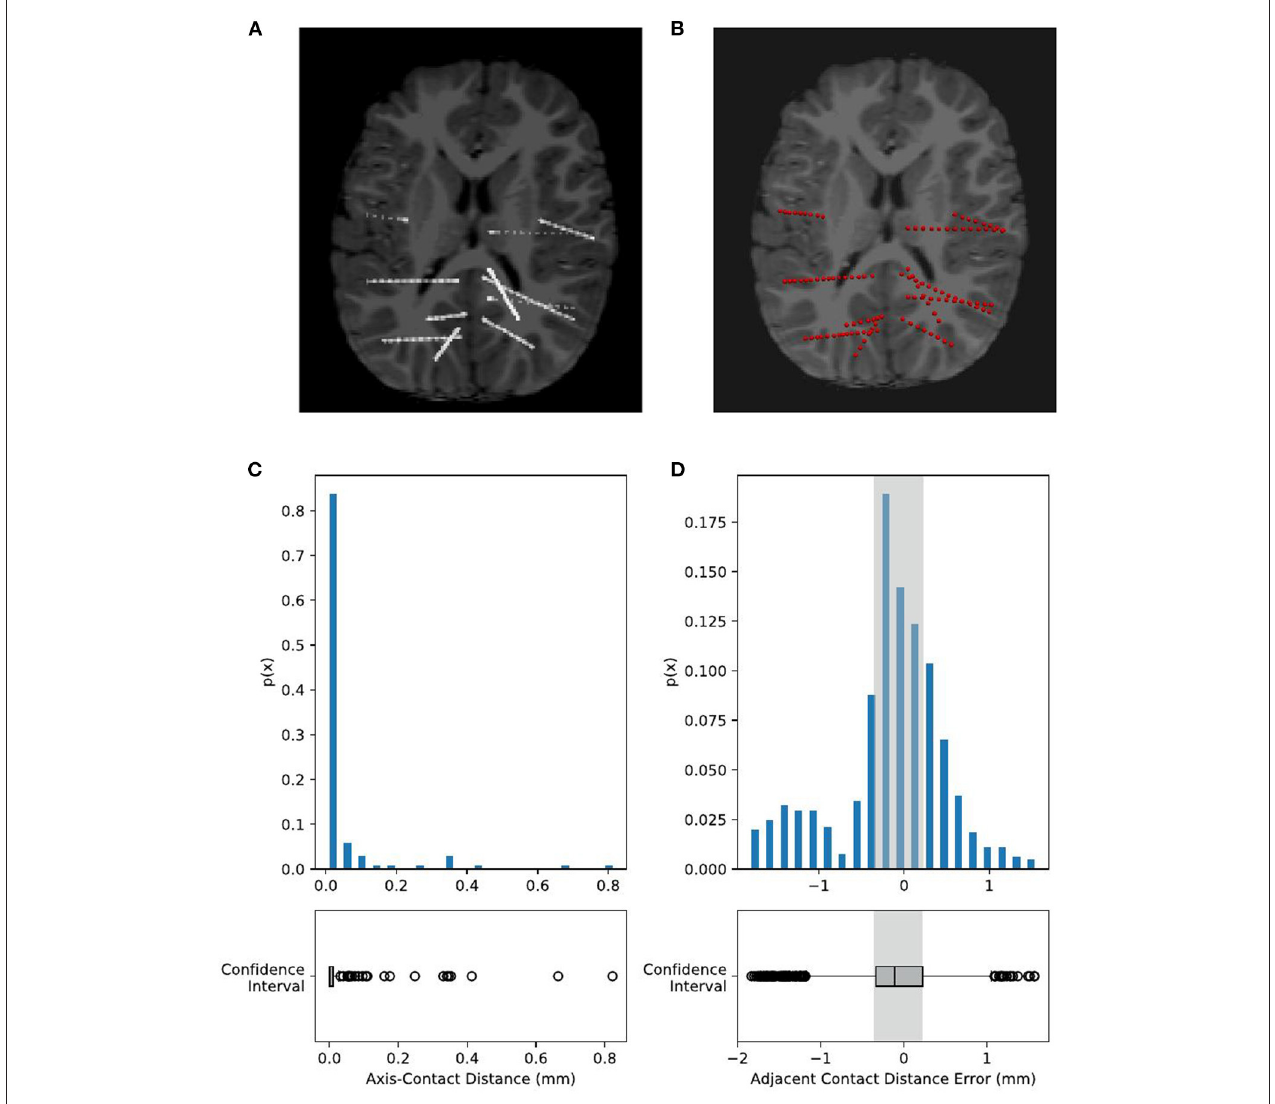
FIGURE 7 | Validation of electrode localization accuracy. Visual checking of the electrodes and contacts of an example subject projected onto the CT image of an individual. The raw CT brain (A) shows electrode positions as highlighted line-shaped voxels. Our recognized electrodes (red spheres) are plotted on (B) , showing that they are overlapped with each other. Contact positions are quantitatively estimated by two metrics, namely, axis-contact distance and adjacent contact distance error. (C) Axis-contact distance estimates the distribution of deviation distance between each contact and its regressed electrode shaft line. Of note, 95% of the contacts were less than 0.1mm, deviating from their estimated shaft line. (D) Adjacent inter-contact distance error estimates the distribution of the distance between each pair of adjacent contacts. The actual adjacent contact distance size, 3.5mm, is subtracted from the estimated distances, so here we have shown the distribution of the adjacent contact distance error. Notably, 95% of the contact distance fell in the range of 0 ± 1mm, and 50% of the contact distance fell in the range of 0 ± 0.3mm, i.e., the adjacent contact distance distribution is 3.5 ± 1mm (95%) and 3.5 ± 0.3mm